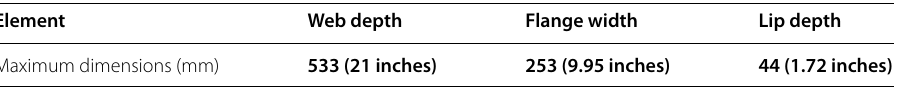
Table 3 The maximum dimensions of the different elements of C-section considering the width to thickness ratio as specified by AISI at a constant thickness of 2.667 mm (0.105 inches)